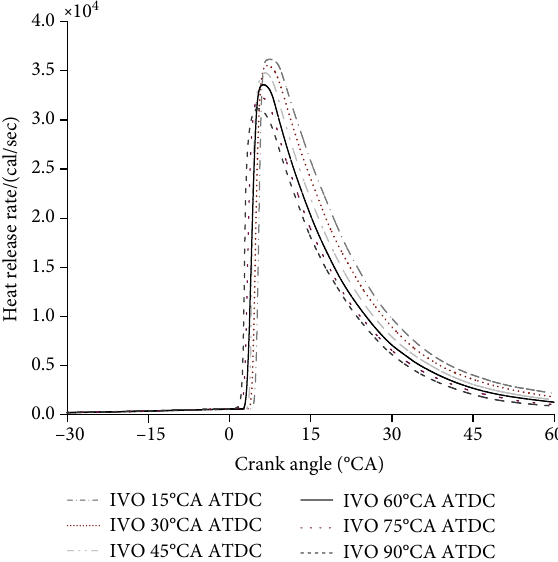
Figure 17: In fl uence of delayed IVO on heat release rate.